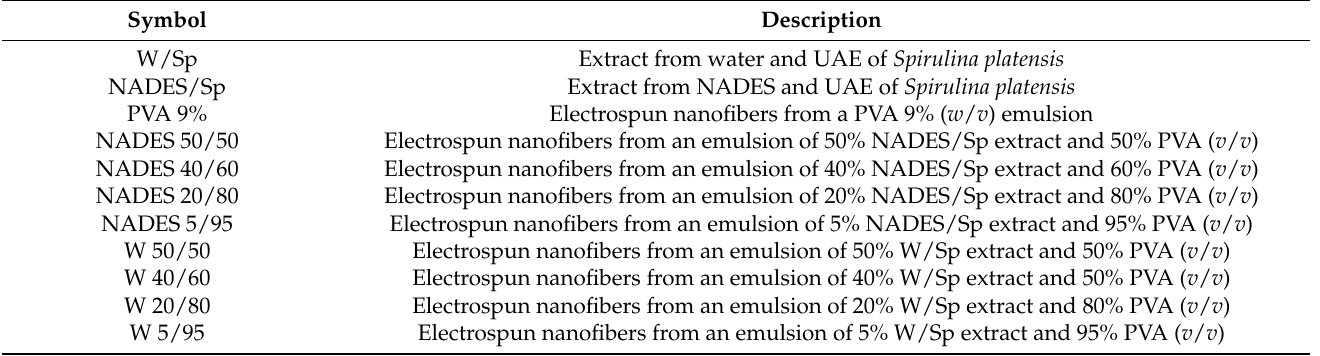
Table 1. Nomenclature used in the article. Symbol Description W/Sp Extract from water and UAE of Spirulina platensis Extract from NADES and UAE of Spirulina